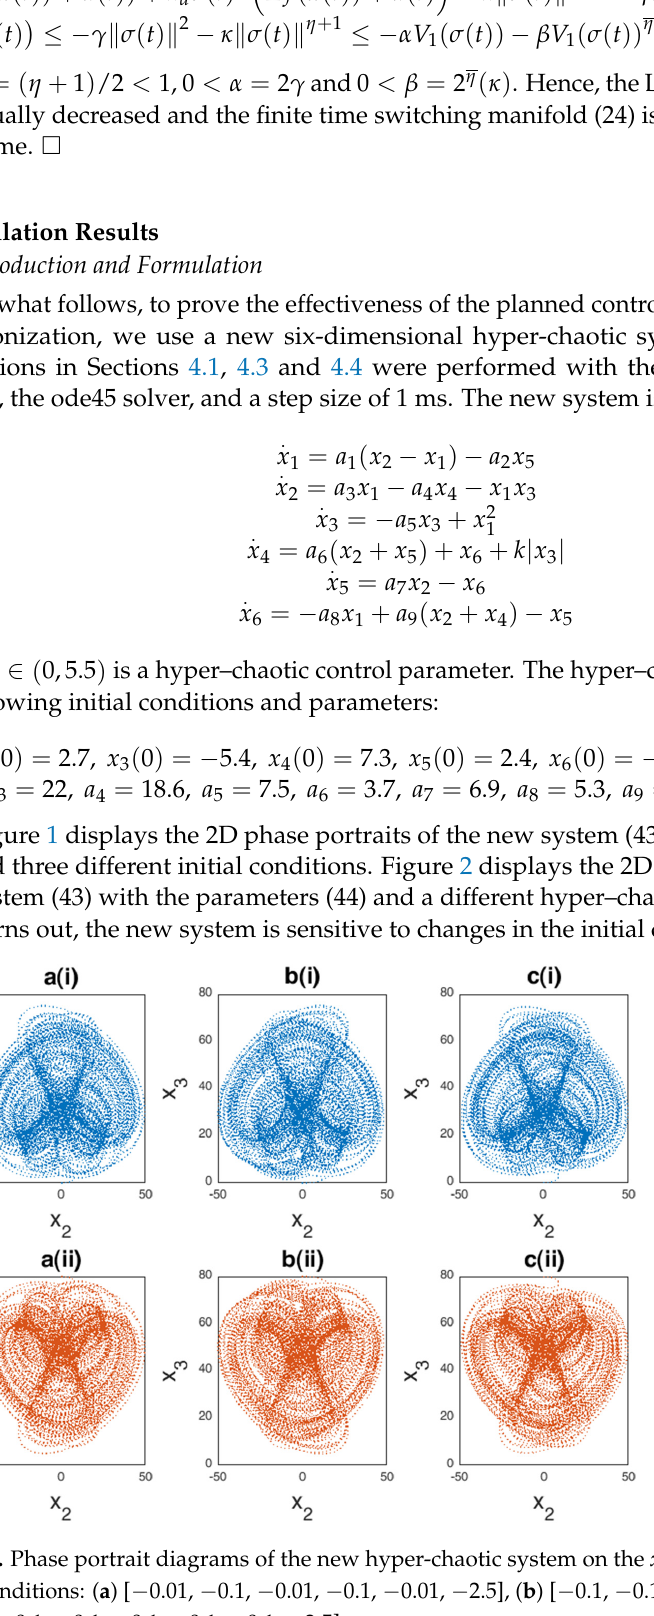
Figure 2. Phase portrait diagrams of the new hyper-chaotic system on the 𝒙 𝟏 − 𝒙 𝟐 space for differ- ent hyper–chaotic control parameters: ( a ) [ k = 0.002], ( b ) [ k = 0.2], ( c ) [ k = 0.85] and ( d ) [ k = 1]